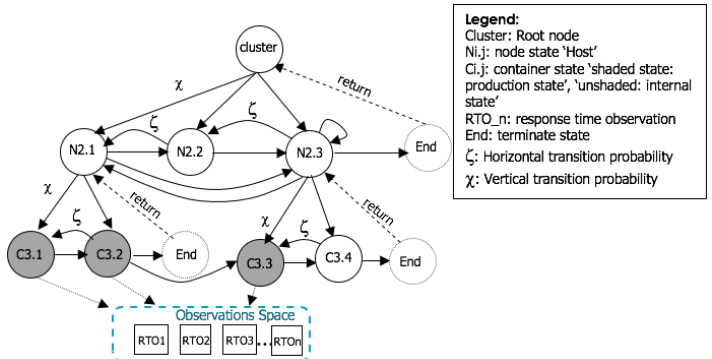
Figure 1. Anomaly detection and localization based on